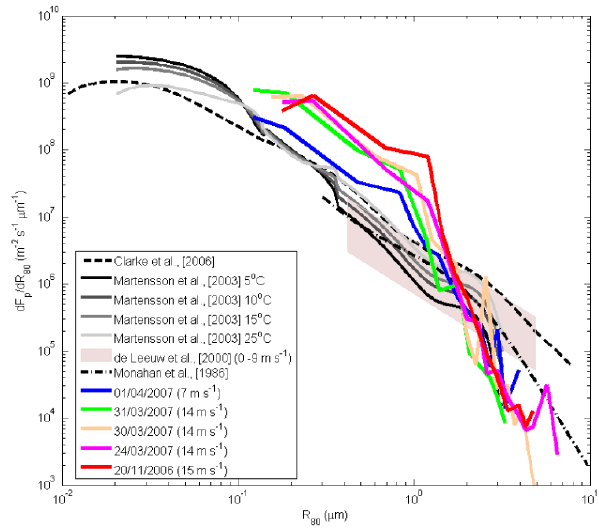
Fig. 8. The mean production flux per unit area of whitecap for each deployment. The production flux functions from previous studies utilizing similar methods are also shown for comparison. The pink shaded area shows the range of the production fluxes estimated by de Leeuw et al. (2000) for a range of wind speeds between 0 and 9ms − 1 . The error estimate for the estimated production flux is the same for all the SEASAW deployments: